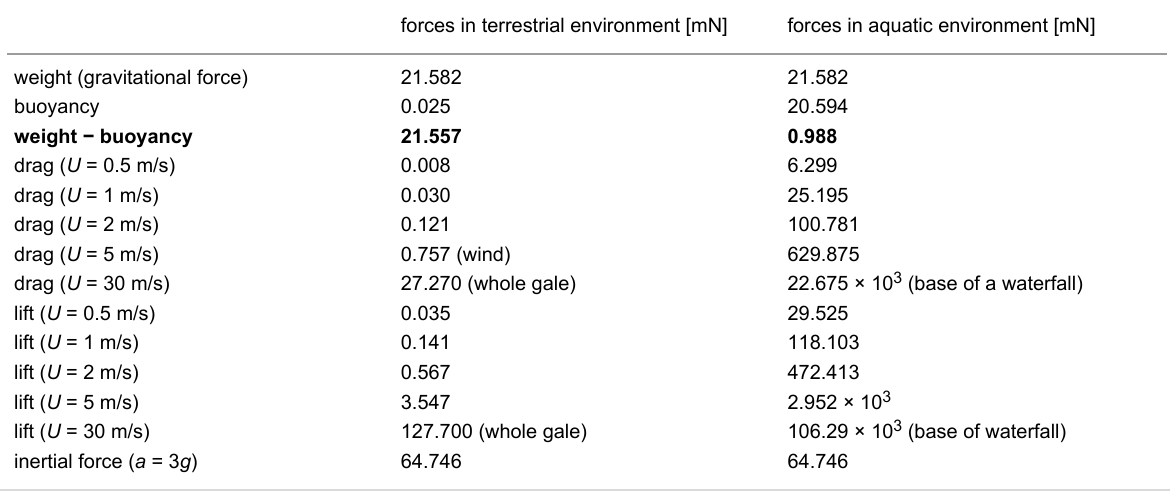
Table 3: Calculation of the detachment forces of a theoretical hemispherical organism (mass: 2.2 g and radius: 1